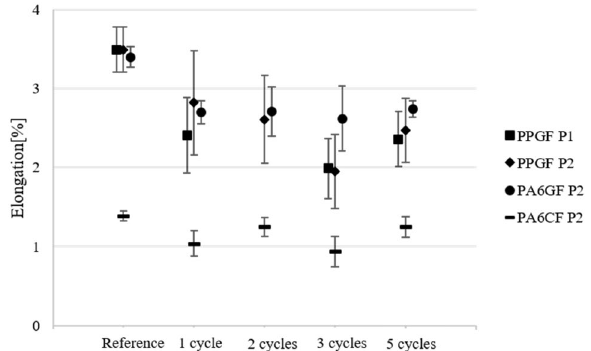
Fig. 11 Tensile test results for